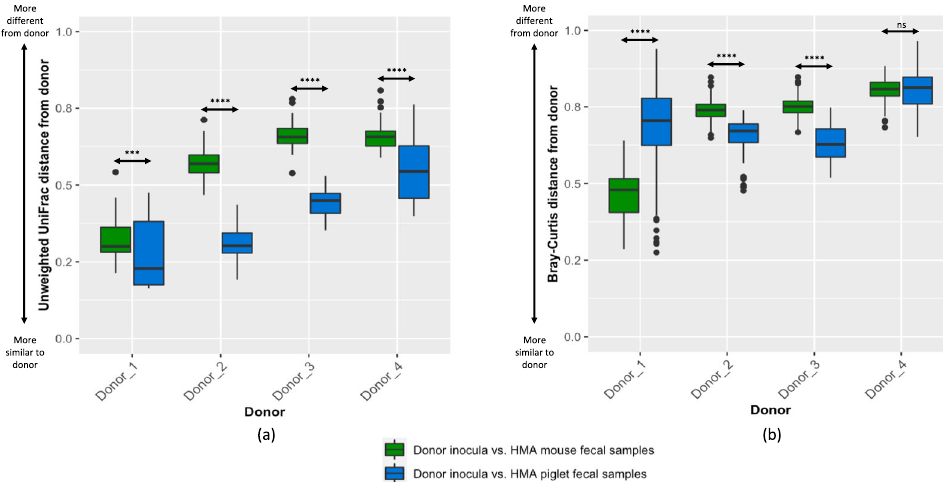
Fig. 3 Comparison of similarity of HMA animal fecal bacterial communities and corresponding human donor bacterial communities. ( a ) Unweighted UniFrac distances and ( b ) Bray – Curtis distances. The box represents the 25th and 75th percentiles as the interquartile range (IQR) and the short black line represents the median. The whiskers represent the minimum and maximum values. Outliers are shown as black dots. Statistical comparisons were performed using the Wilcoxon rank-sum test. *** p < 1 × 10 − 5 ; **** p < 1 × 10 − 10 ; ns – not signi fi cant. n = 13 (3 piglets/donor, with the exception n = 4 for